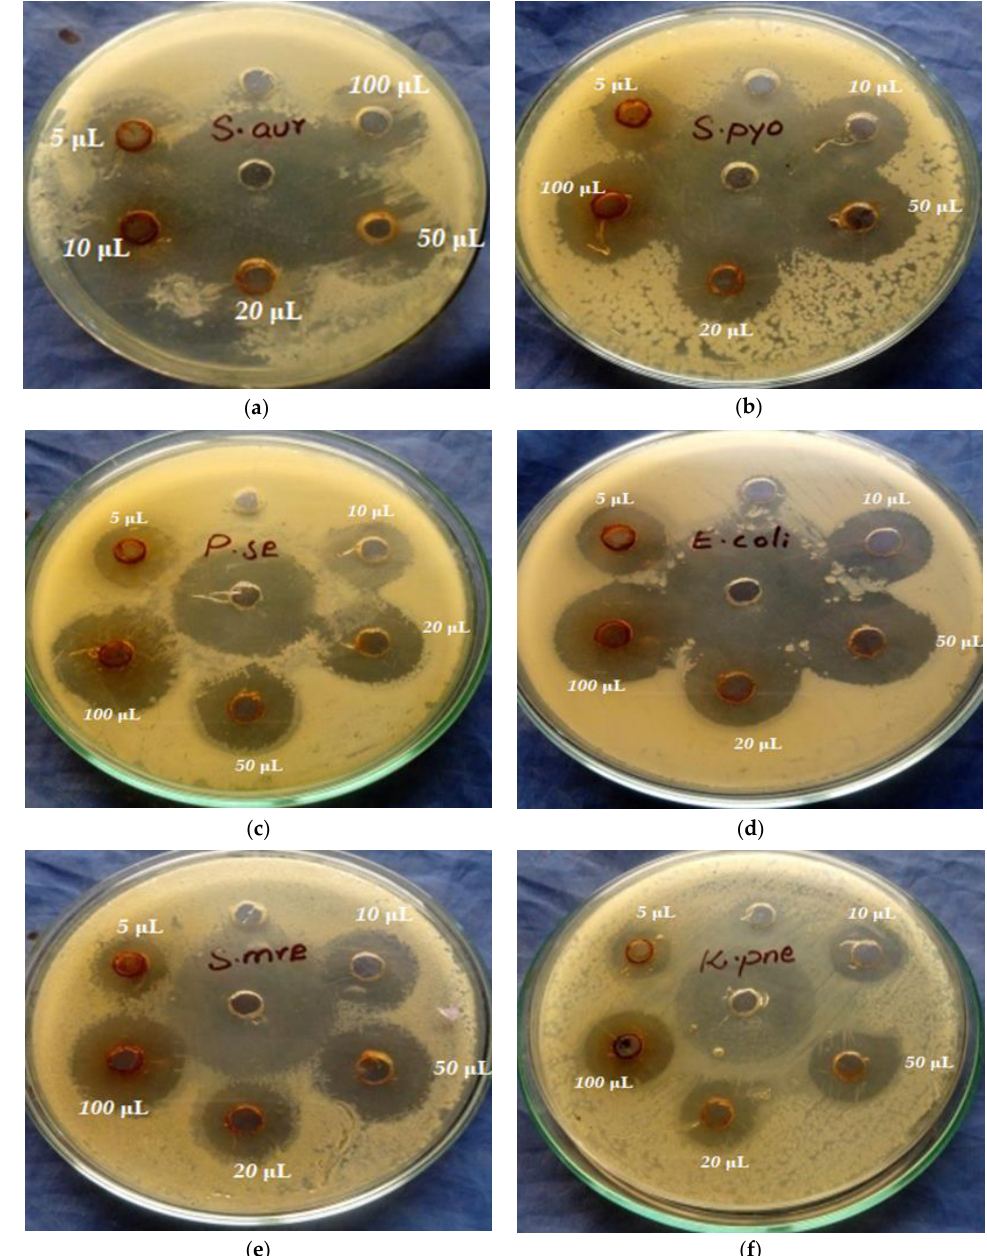
Figure 7. Pictorial representation of antibacterial activity of CuO NPs; where ( a ) S. aureus , ( b ) S. pyogens , ( c ) S. epidermis , ( d ) E. coli , ( e ) S. marcescom and ( f ) K. pneumonia